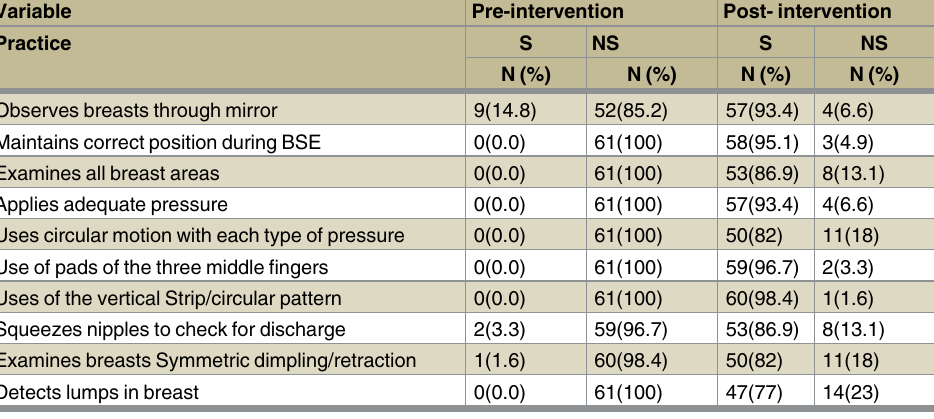
Table 2. Distribution of the practical competency of BSE among respondents in HawassaHealth Sci- ences College, 2015 (N = 61).